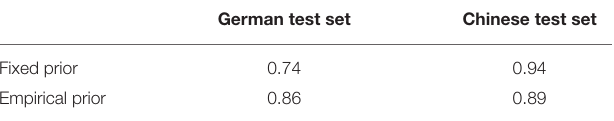
TABLE 5 | Pearson product-moment correlation coefficients between average information content per rhythm under the German and the Chinese model, showing the degree to which information-content assigned to the same rhythms by both models is related.